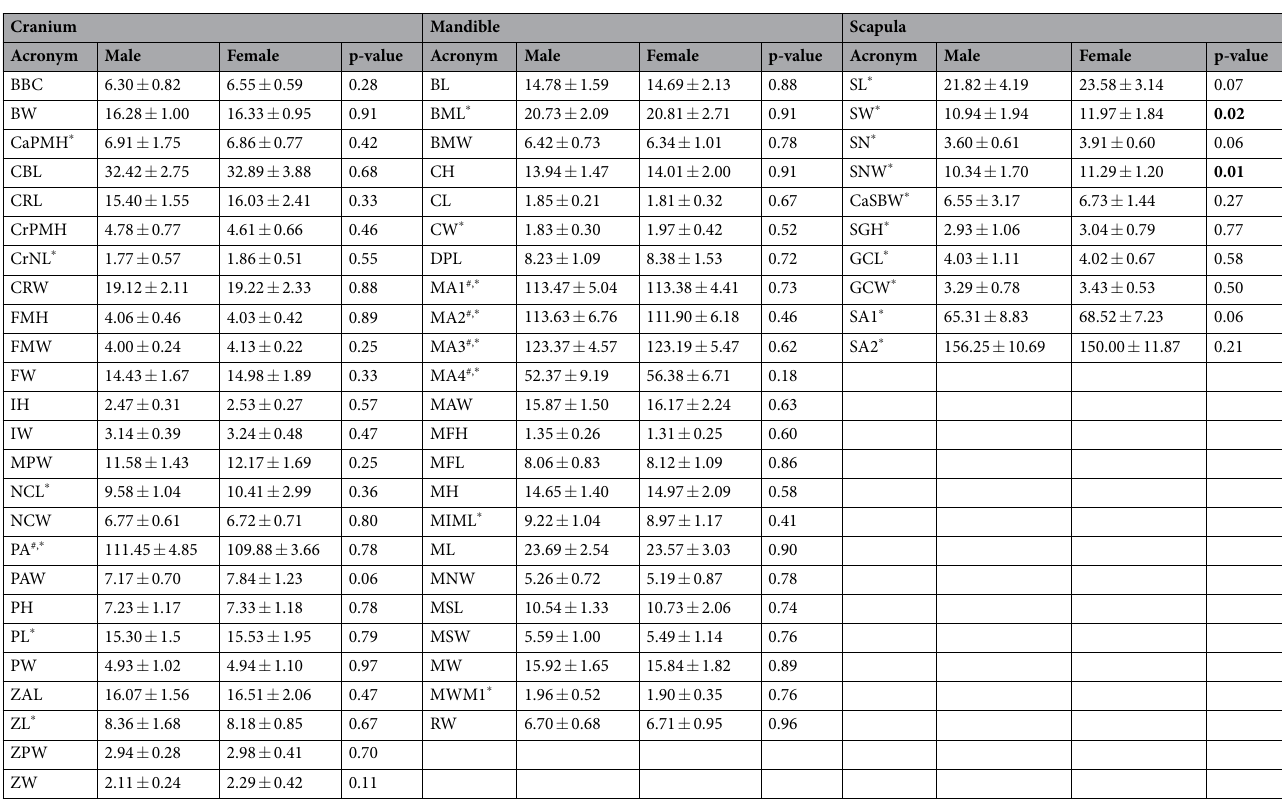
Table 4. Measurement data (mean ± SD) taken from dugong skulls (cranium and mandible) and scapulas, by sex. All parameters are in cm, except superscript # indicates units in degrees. * Non-normally distributed parameter using Mann-Whitney U test for testing a significant difference.